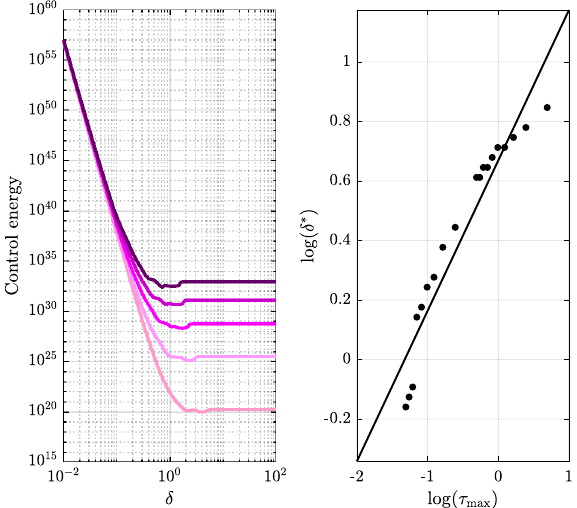
Figure 3. Network temporality and time scales. We consider 19 temporal networks with n = 100 nodes over m = 3 snapshots and differing only in the dominant time constant τ max that is chosen as a measure of the network time scale (see Supplementary Information section S2). The left panel shows the expected control energy averaged over all possible final states x ( t m ) on the unit hypersphere centered in the origin for 5 of the 19 networks. The plot illustrates that the network becomes more energetically demanding and that the minimum point of the energy shifts towards faster temporality regimes as τ max becomes smaller (i.e., as the curves become darker). The right panel highlights the relation between temporality and time scales, with the black dots representing log (δ ∗ ) as a function of log (τ max ) for each of the 19 networks. Specifically, the minimum point δ ∗ , numerically obtained, corresponds to the value of δ associated to the minimum expected control